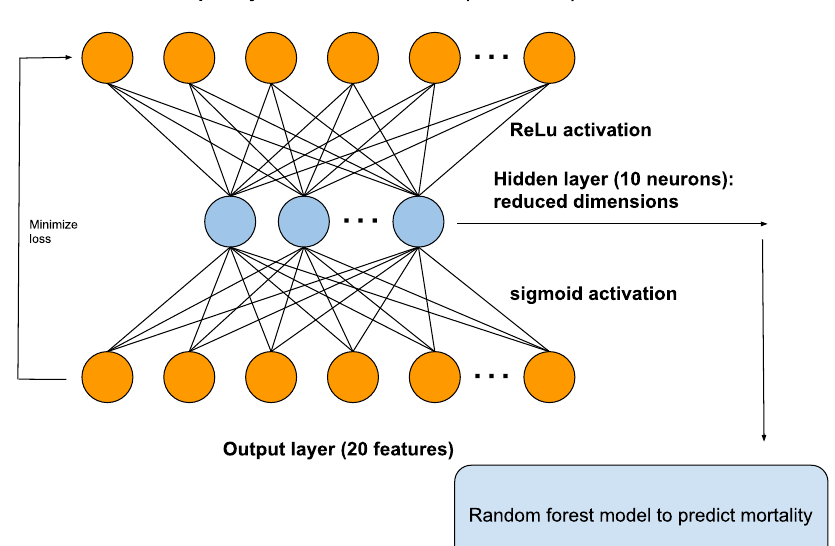
Fig. 5 Architecture of autoencoder. The autoencoder takes as input the bio-social features. The output layer is used to reconstruct the input. The hidden layer of the autoencoder is used for dimensionality reduction. We use the hidden layer as input to a random forest model to predict mortality. The hidden layer is composed of 10 neurons.